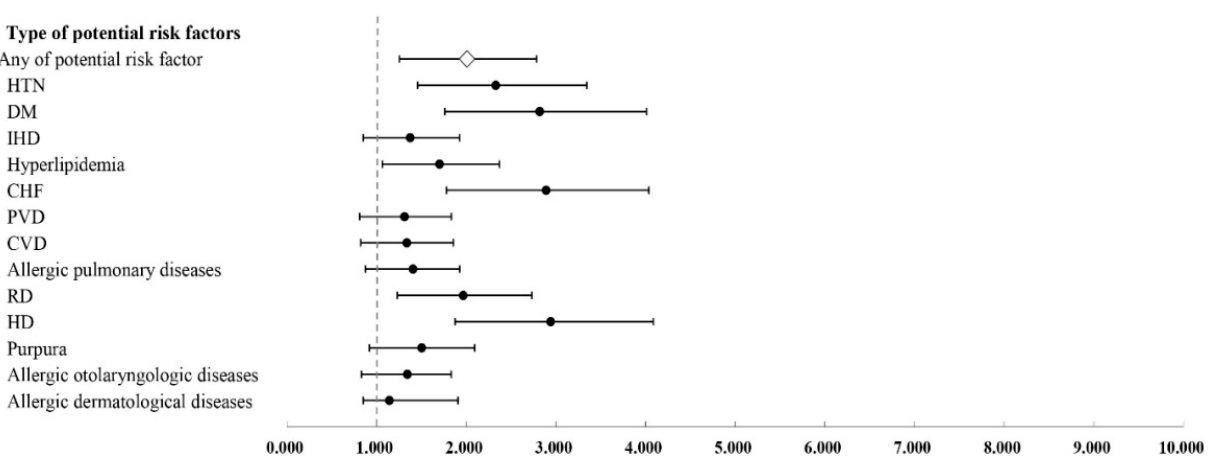
Figure 2. Forest plot for risk factors for cataract surgery with serious complications analyzed using multivariable conditional logistic regression.